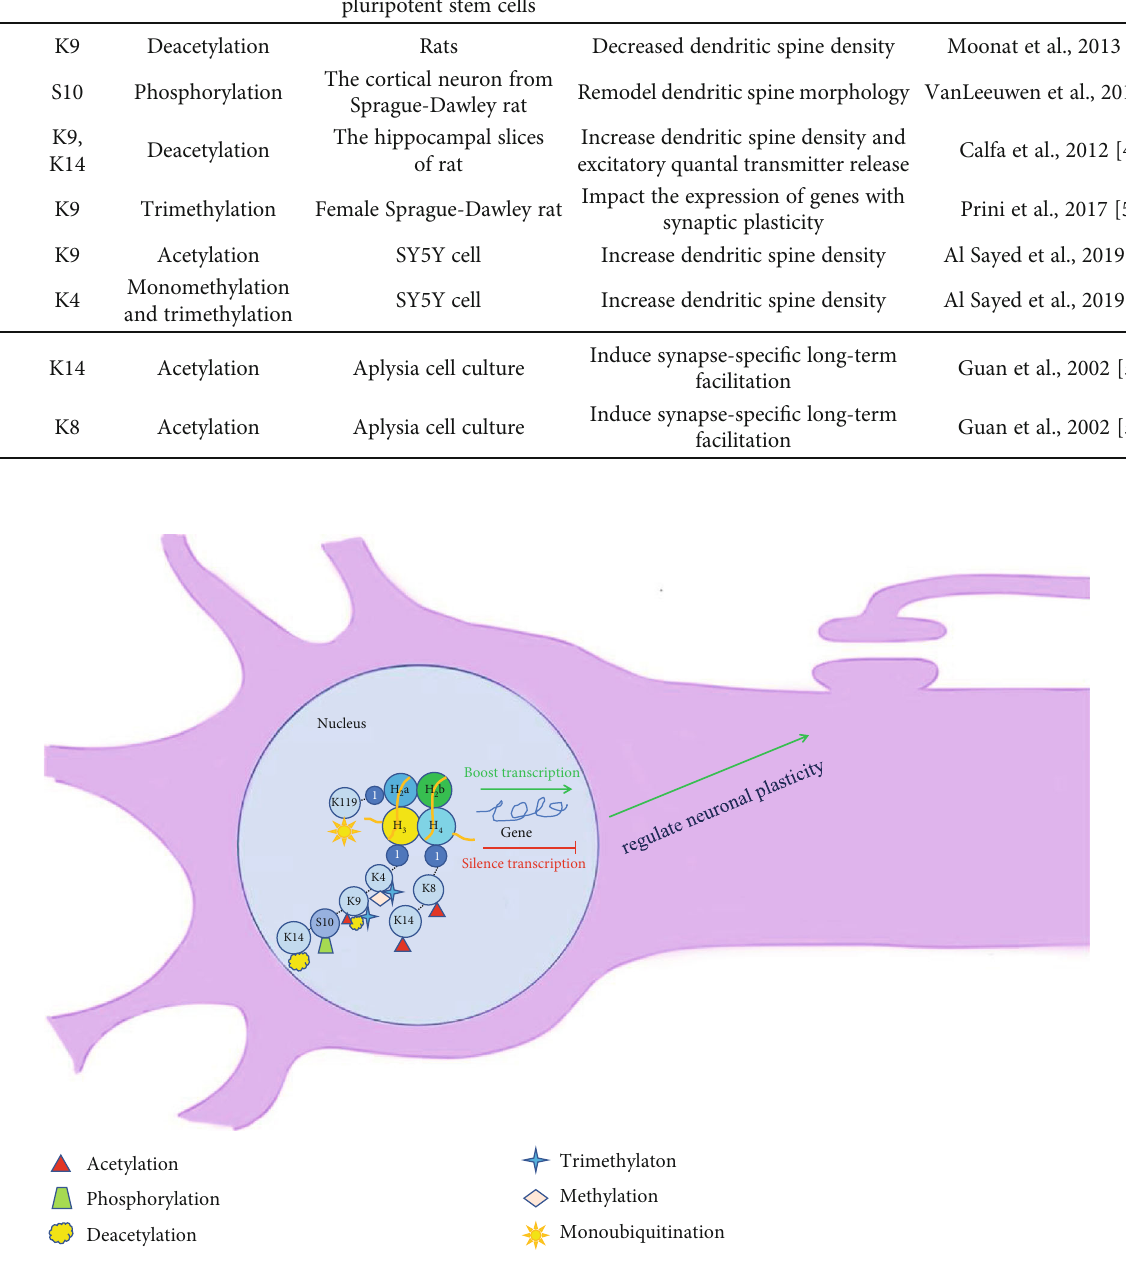
Figure 1: Histone modi fi cation mediates neuronal